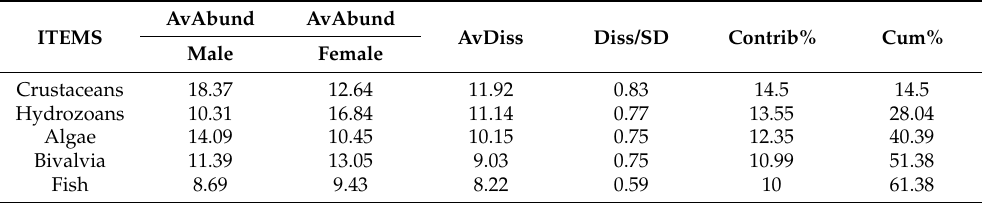
Table 5. Contribution of principal food items (%) to dissimilarity in stomach contents between males and females of Lithodes santolla from Cabo de Hornos. Av.Abund = average abundance of prey item, Av.Diss = average dissimilarity, Diss/SD = average contribution divided by the standard deviation, Contrib% = Contribution to the dissimilarities, Cum% = Cumulative contribution to the dissimilarities. All items representing